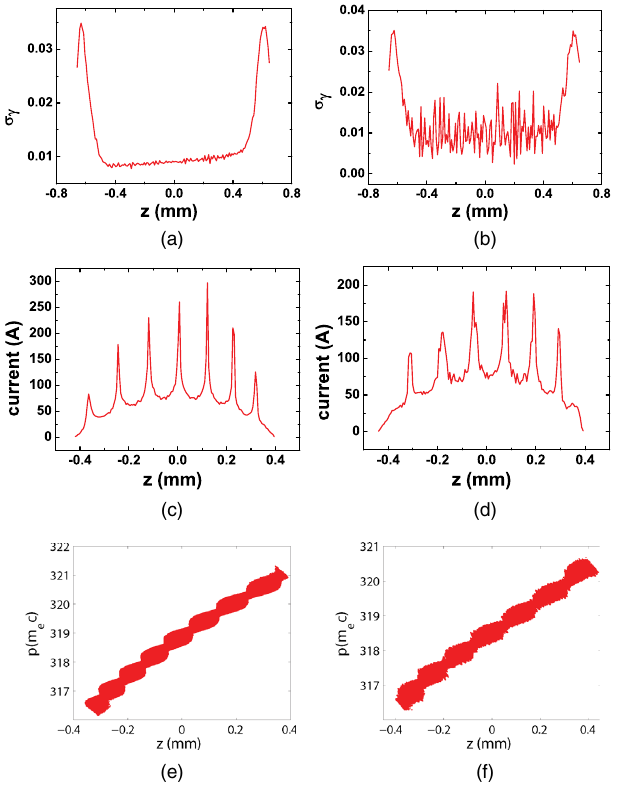
FIG. 10. Comparison between LSC effect off (left) and on (right). (a) Slice energy spread at the entrance of modulator 1, LSC off. (b) Slice energy spread at the entrance of modulator 1, LSC on. (c) Beam current at the exit of dispersion 2, LSC off. (d) Beam current at the exit of dispersion 2, LSC on. (e) Longi- tudinal phase space at the exit of dispersion 2, LSC off. (f) Longi- tudinal phase space at the exit of dispersion 2, LSC on.